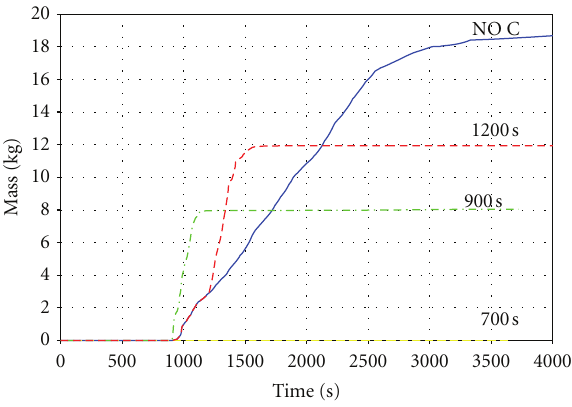
Figure 10: Soluble fission products released. HPCS injection to 700s, 900 s, and 1200 s; NO C indicates without HPCS